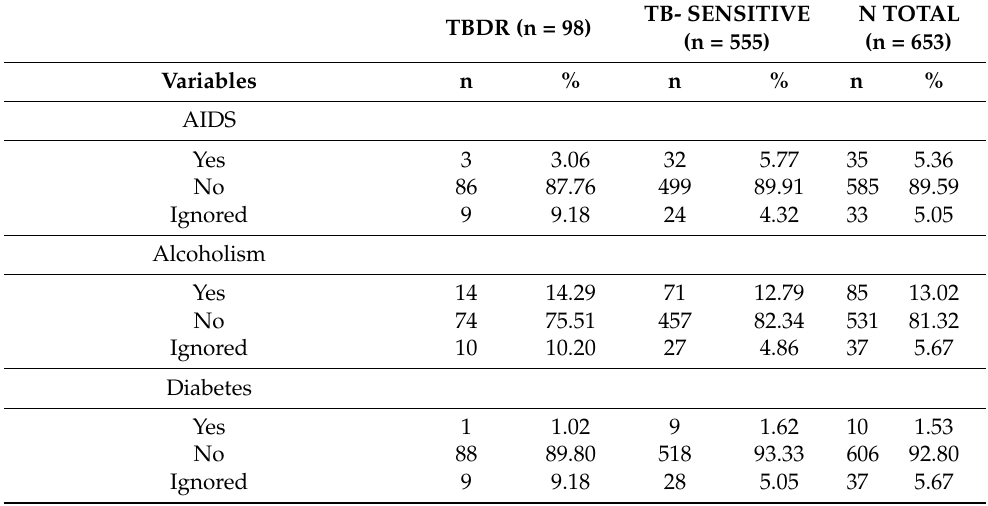
Table 2. Risk factors and characteristics regarding the diagnosis of tuberculosis in adults deprived of liberty reported between 2008 and 2018 in the State of Paran á ,